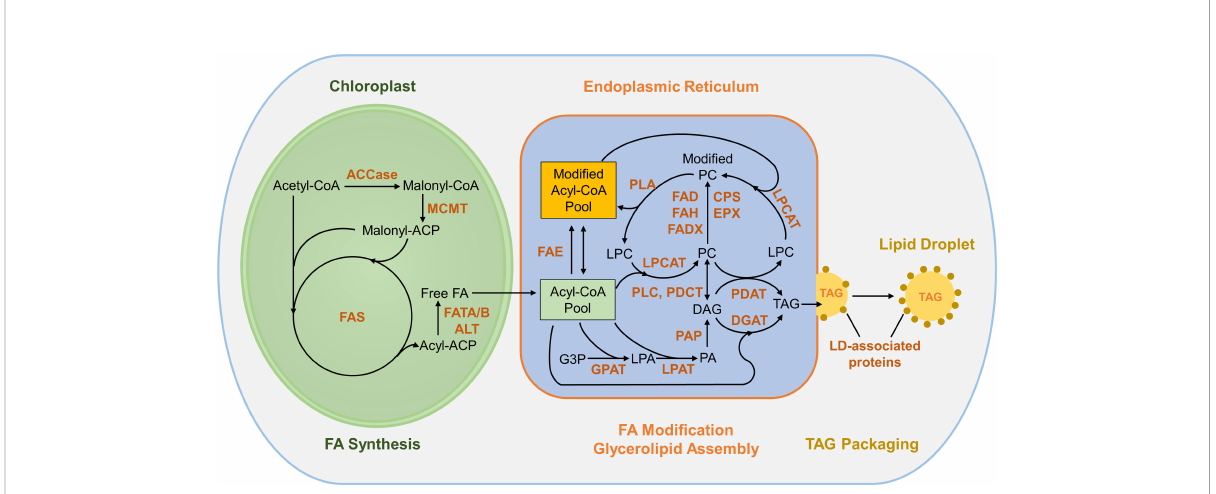
FIGURE 1 Overview of FA synthesis and TAG assembly in plants. The conversion of acetyl-CoA to malonyl-CoA by ACCase is the fi rst committed step in fatty acid synthesis in plastids. With acetyl-CoA serving as the starting unit, the acyl chain is extended by sequential condensation of two-carbon units from malonyl-ACP by FAS complex. FAs exported from plastids enter the acyl-CoA pool in the ER and can be incorporated into PC, where acyl groups are modi fi ed and re-enter the acyl-CoA pool thorough acyl editing. The Kennedy pathway incorporates acyl-CoA into glycerolipids via sequential acylation of G3P by GPAT, LPAT and DGAT. TAG can be synthesized through acyl-CoA-dependent (DGAT converting DAG and acyl-CoA to TAG) and acyl-CoA-independent (PDAT synthesizing TAG from DAG and PC) pathways. TAGs are packaged into LDs and protected by LD-associated proteins. ACCase, acetyl-CoA carboxylase; ACP, acyl carrier protein; CoA, coenzyme A; MCMT, malonyl-CoA: ACP malonyltransferase; FAS, fatty acid synthase; FATA/B, fatty acyl thioesterase A/B; ALT, acyl-lipid thioesterase; FAE, fatty acid elongase; GPAT, glycerol-3-phosphate acyltransferase; LPAT, lysophosphatidyl acyltransferase; PAP, phosphatidic acid phosphatase; DGAT, diacylglycerol:acyl- CoA acyltransferase; PDAT: phospholipid:diacylglycerol acyltransferase; PLC, phospholipase C; PDCT, phosphatidylcholine:diacylglycerol cholinephosphotransferase; LPCAT, lysophosphatidylcholine acyltransferase; PLA, phospholipase A; CPS, cyclopropane synthase; EPX, epoxygenase; FAD, fatty acid desaturase; FAH; fatty acyl hydroxylase; FADX, fatty acid conjugase; G3P, glycerol-3-phosphate; LPA, lysophosphatidic acid; PA, phosphatidic acid; DAG, diacylglycerol; PC, phosphatidylcholine; LPC, lysophosphatidylcholine; TAG,